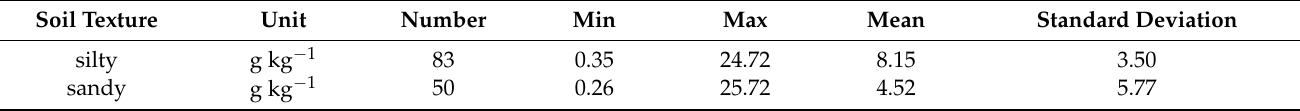
Table 1. Classification and statistics of soil